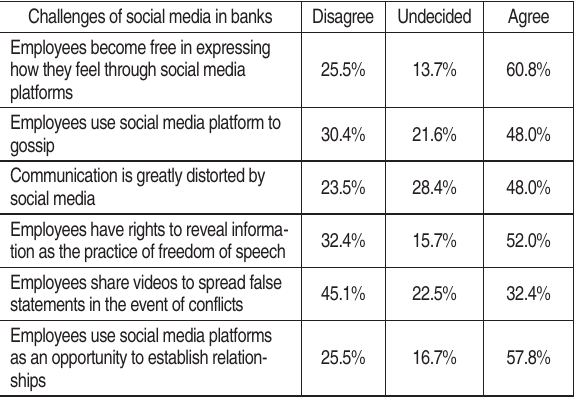
Table 5. Challenges of social media in banks Challenges of social media in banks